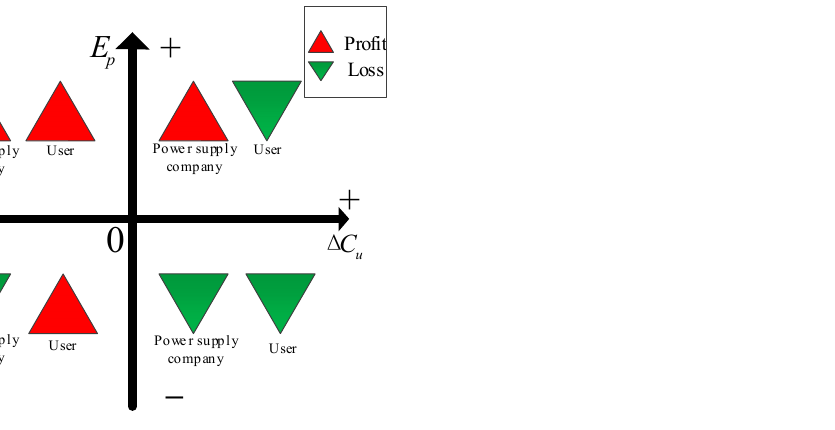
Figure 1. Changes in user electricity cost and power supply company electricity sales profit after DSM implementation.